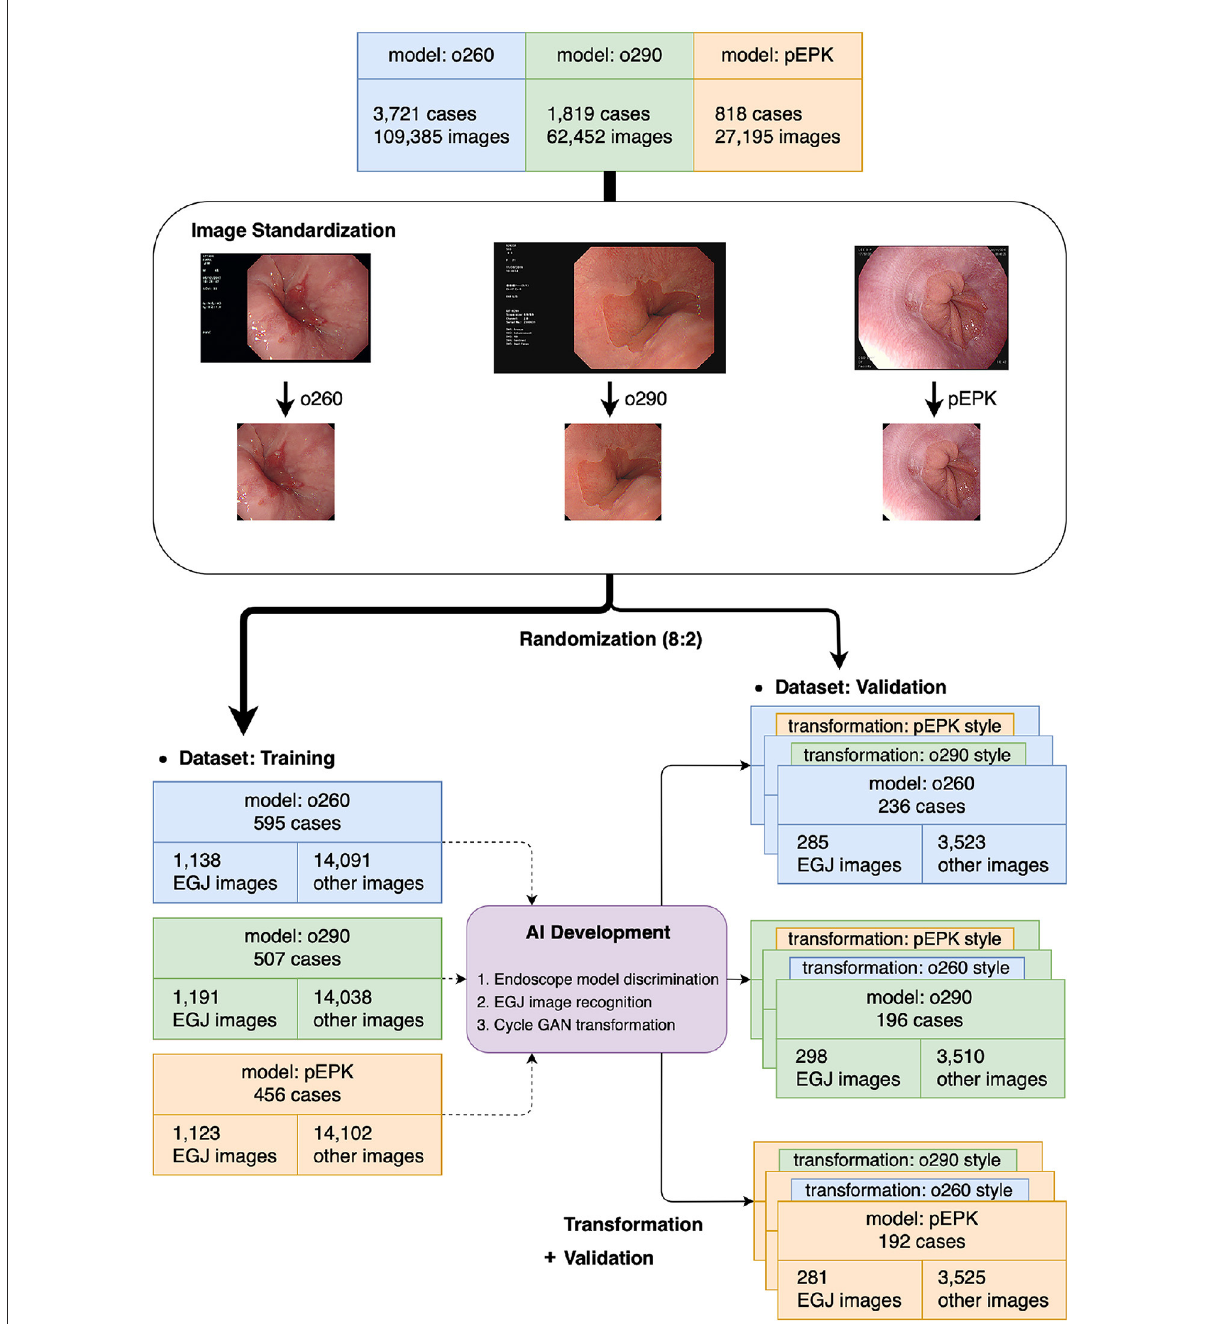
FIGURE1 Flowchart of the present study. The images extracted from the original were distributed to the training and validation datasets at a ratio of 8:2 after the standardization process was completed. The AIs were trained using the training dataset and verified in the validation dataset and its transformed images using cycleGAN to obtain the characteristics of other endoscope models. o260, Olympus CV-260SL; o290, Olympus CV-290; pEPK, PENTAX EPK-i; AI, artificial intelligence; EGJ, esophagogastric junction; GAN, generative adversarial network.